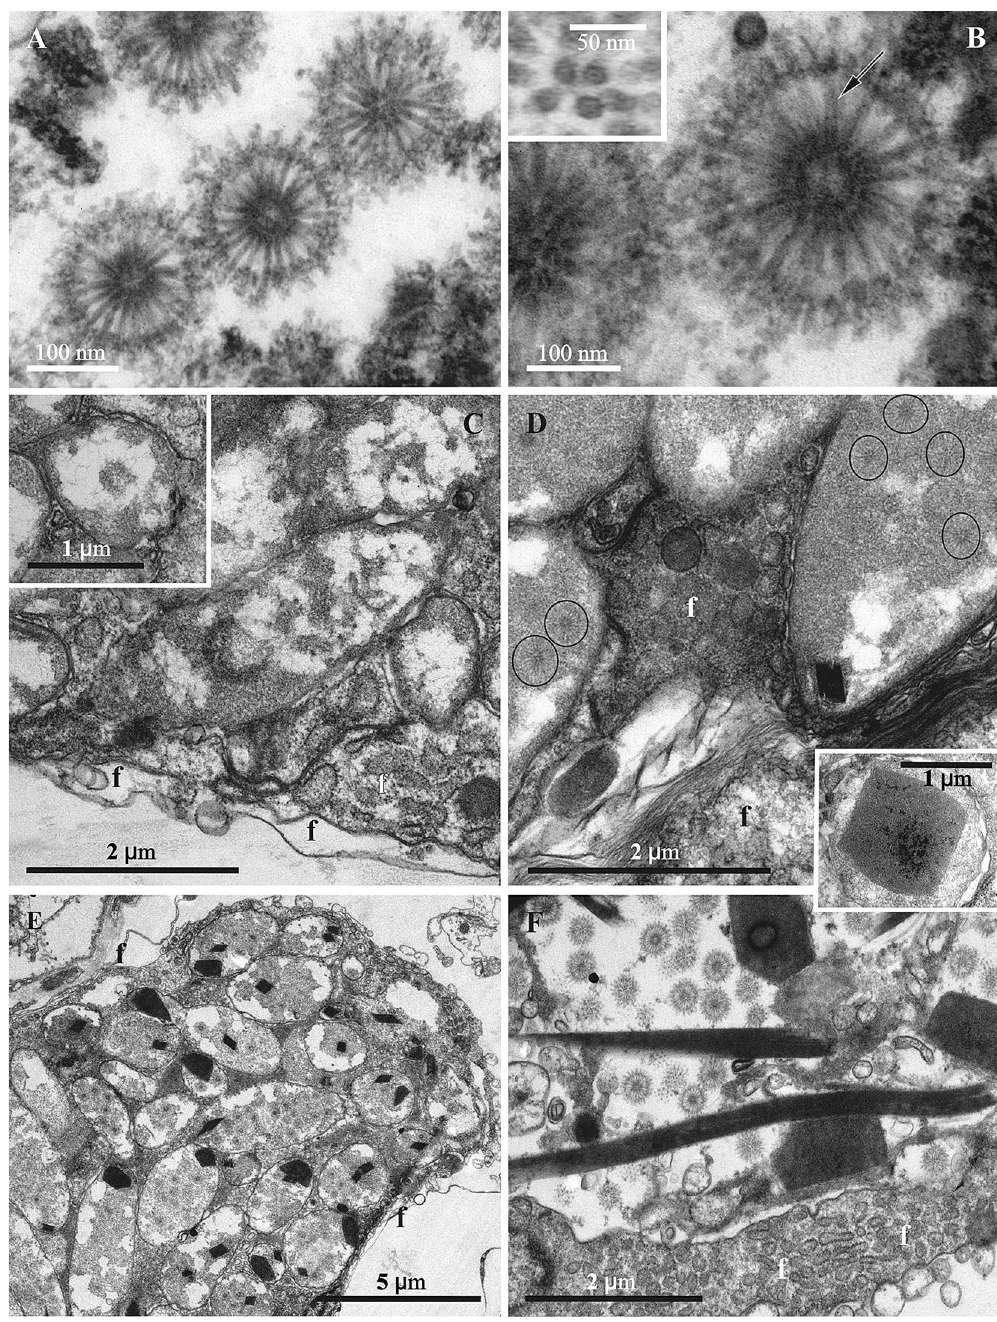
Figure 9. ( A , B ) Structures presumably derived from viruses in bacterial symbionts of Paralicornia sinuosa . Insert: cross-section of radial cylinders showing darker periphery and lighter central part (also shown by arrow in B ) with a dark central ‘spot’. ( C – F , insert), various stages in the lytic cycle of bacteriophages in the symbiotic bacteria of P. sinuosa . ( C ) and insert, longitudinal and cross-sections of non-/less altered bacteria (‘type I’ cells) inside funicular cord. ( D ) VLP (in circles) becoming visible inside bacteria predominantly filled with electron- dense cytoplasm (‘type II’ cells), nucleoid is fragmented and poorly recognizable; insert shows paracrystalline body at higher magnification. ( E ) bacteria (‘type III’ cells) filled with viruses and paracrystalline structures. ( F ) bacteriophages and paracrystals inside the cavity of the funicular cord after bacterial destruction. TEM. Abbreviations: f, cells of funicular